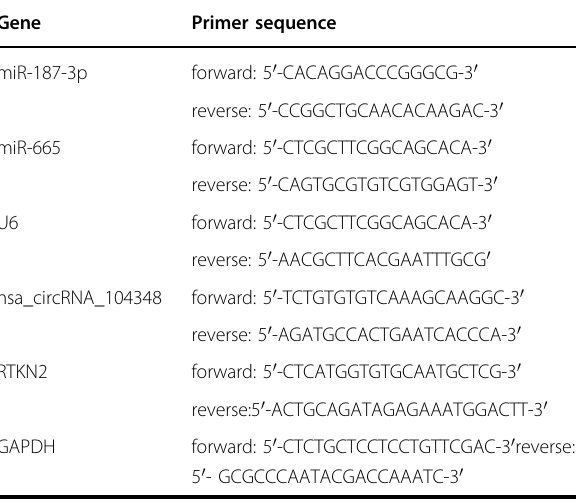
Table 1 Primers used in the present